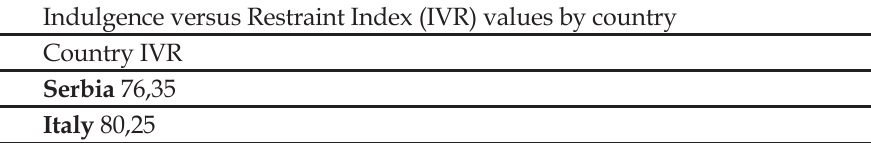
Table 7. Indulgence versus Restraint Index (IVR) values by country.